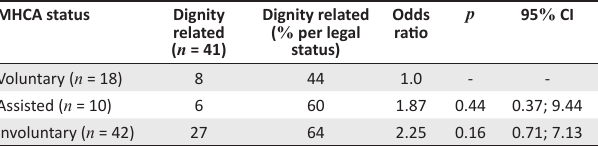
FIGURE 1: Proportion of dignity-related complaints per Mental Health Care Act status category ( n = 70). TABLE 3: Association between Mental Health Care Act status and dignity-related